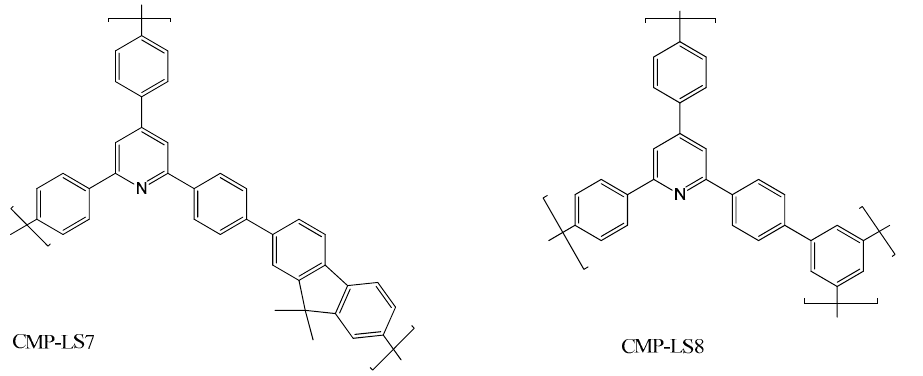
Figure 6. Chemical structure of CMP-LS7 and CMP-LS8.